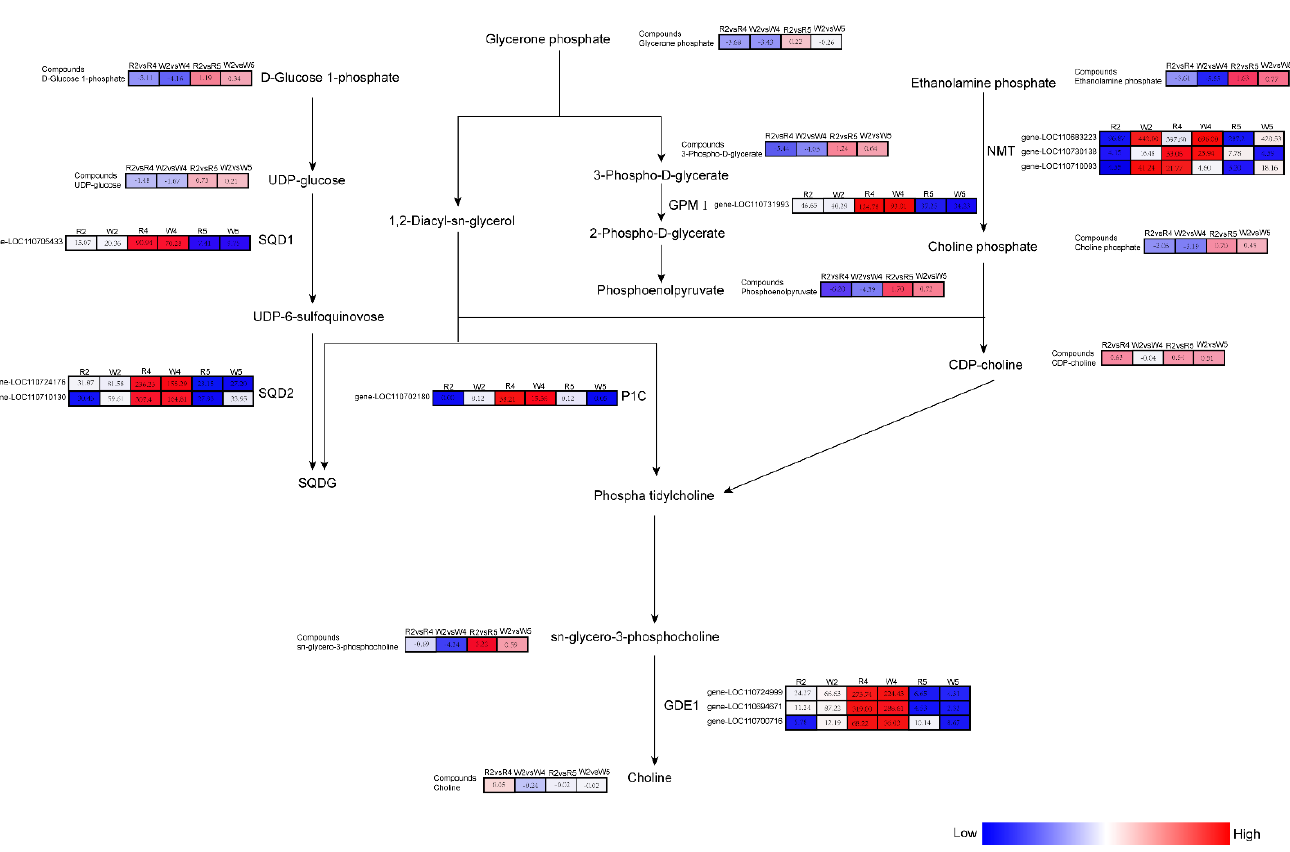
Figure 7. Response mechanisms of the Glycerophospholipid metabolism, Glycerolipid metabolism, and Glycolysis/Glyconeogenesis pathways in quinoa seedlings subjected to various phosphorus levels. The FPKM values indicate the gene expression levels. The log2fc values between comparisons indicate the metabolite expression levels. DEGs and DEMs are represented by boxes in pathways. Red and blue represent gene expression levels and metabolite upregulation and downregulation, respectively. SQD1, UDP-sulfoquinovose synthase; SQD2, sulfoquinovosyltransferase; GPM Ⅰ , 2,3-bisphosphoglycerate-independent phosphoglycerate mutase; P1C, phospholipase C; GDE1, glycerophosphodiester phosphodiesterase; NMT, phosphoethanolamine N -methyltransferase.